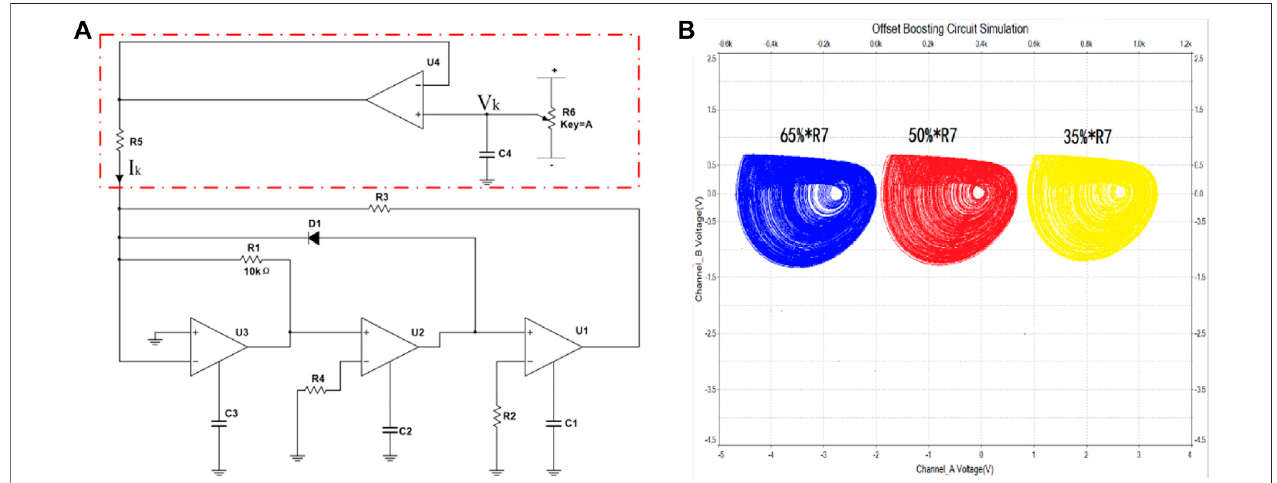
FIGURE 8 | The circuit simulation of offset boosting. (A) The circuit of offset boosting for variable x . (B) The attractors of offset boosting when adjusting for R7 to 35% (blue), 50% (red), and 65% (yellow).